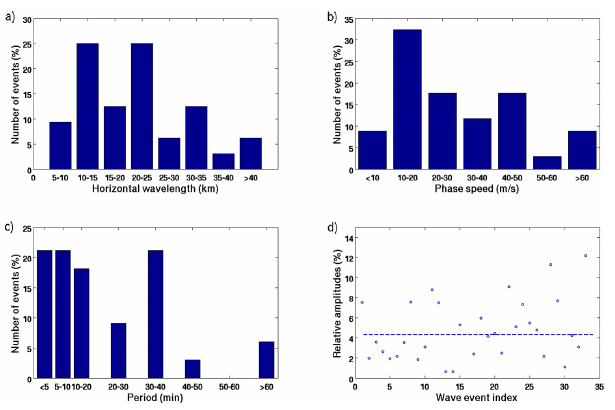
Figure 5. Histogram of the (a) horizontal wavelength, (b) phase speed, (c) period, and (d) relative amplitudes (as determined in Sect. 3.2) for each wave event studied using the camera in Trond- heim (TRD).